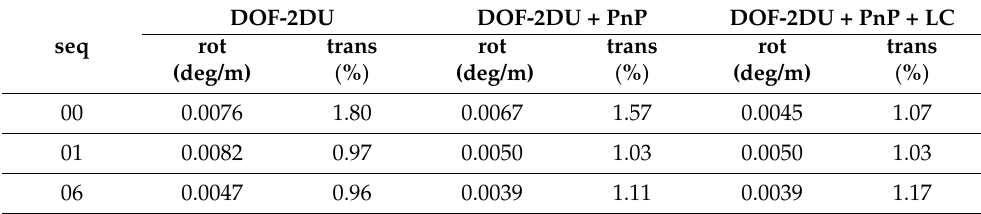
Table 1. Ablation study of our new proposed methods for selected KITTI dataset. “DOF-2DU” is the pose estimate of our Mahalanobis eight-point algorithm using dense optical flow with two- dimensional uncertainty, “+PnP” is the fused pose estimate with perspective-n-point, and “+LC” is the inclusion of loop